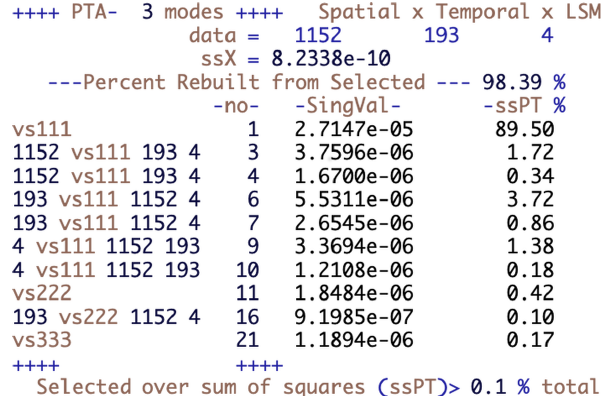
Figure 2. Summary of the PTA3 decomposition for the data table of NPP simulations for the four LSMs for the studied region and period. Each line of the table corresponds to a rank-1 tensor part of the decomposition; the variability (sum of squares) in X it explains is given by the square of its singular value, SingVal , and this is expressed as a percentage of the variability in the ssPT %